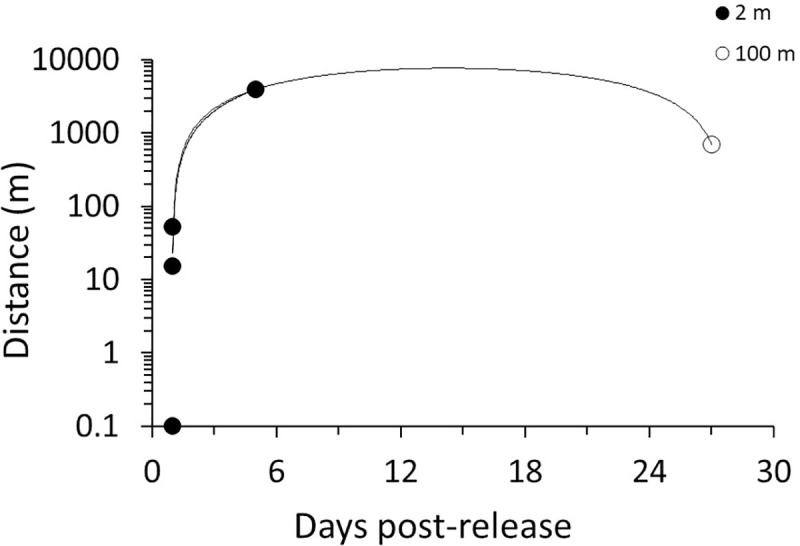
The distance individual molts traveled alongshore from nearshore (2 m, 100 m) release points during the mark-recapture study.